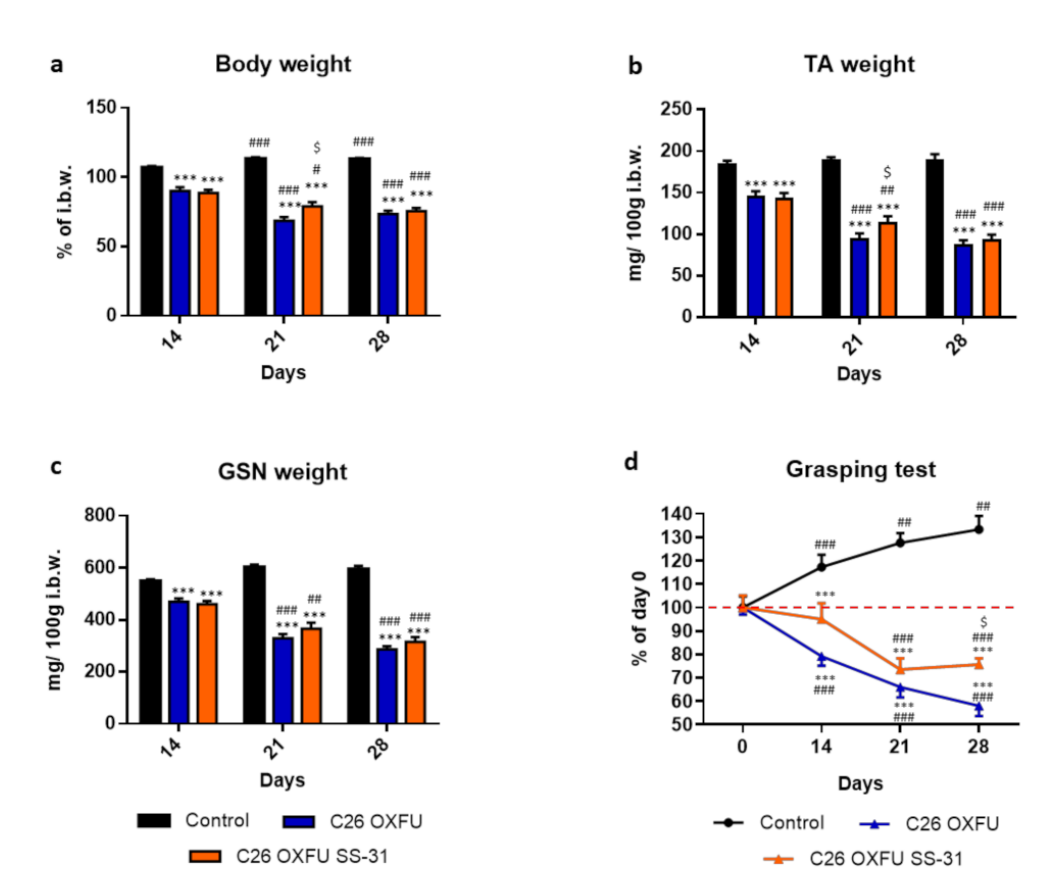
Figure 3. Progressively increasing SS-31 dosage show a therapeutic window in chemotherapy-treated C26-bearing mice. Body weight ( a ), tibialis anterior weight (TA; b ), gastrocnemius weight (GSN; c ) and grasping test of controls ( n = 7) and tumor-bearing mice administered with chemotherapy alone (C26 OXFU; n = 8) or in combination with SS-31 (C26 OXFU SS-31; n = 8) euthanized 14, 21 or 28 days after tumor implantation. Body weight data (means ± SEM) are expressed as percentage of initial body weight (i.b.w.). Muscle weight (means ± SEM) is expressed as mg of tissue per 100g of initial body weight. Grasping test data (means ± SEM) are expressed as percentage of day 0. Significance of the differences: *** p < 0.001 vs. control; # p < 0.05, ## p < 0.01, ### p < 0.001 vs. day 14; $ p < 0.05 vs. C26 OXFU. For grasping test (panel d ) the significance of the difference is *** p < 0.001 vs. day 0; ## p < 0.01, ### p < 0.001 vs. control; $ p < 0.05 vs. C26